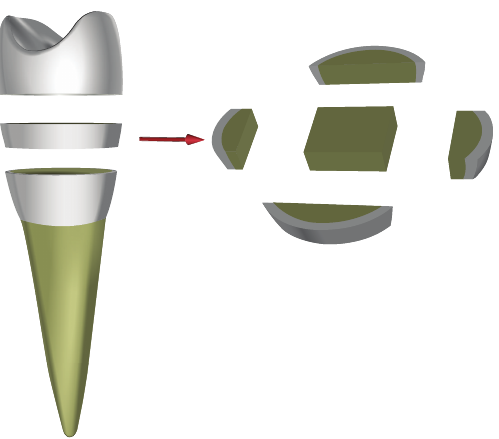
Figure 1: Scheme of cut-off tooth for preparation samples for structure